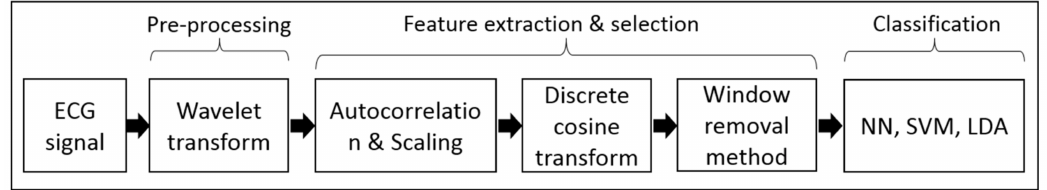
Figure 1. Block diagram of proposed method. EGG: electrocardiogram; NN: nearest neighbor; SVM: support vector machine ; LDA: linear discriminant